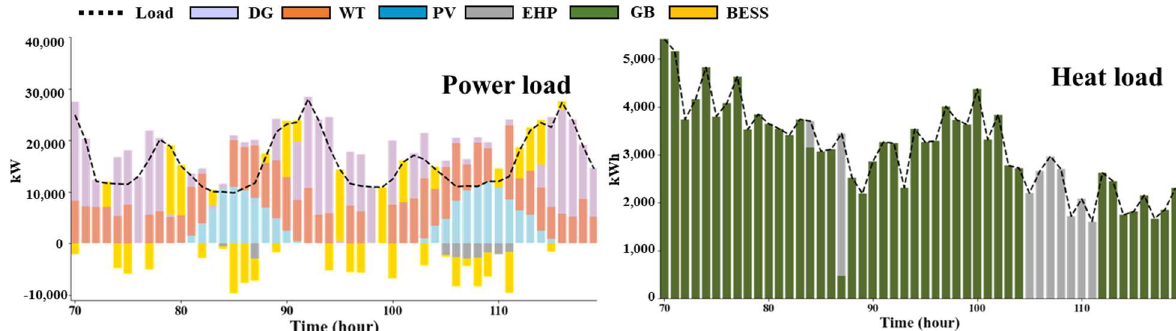
Figure 6. Results of power flow scheduling in Case 2.